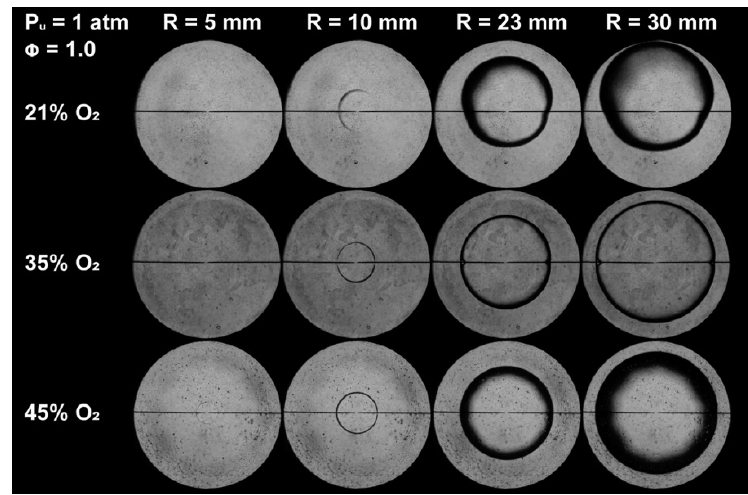
Figure 15. Schlieren images of stoichiometric NH 3 -O 2 -N 2 flames with the O 2 content varying from 21% to 45% at 1 atm. Courtesy of Elsevier [85].